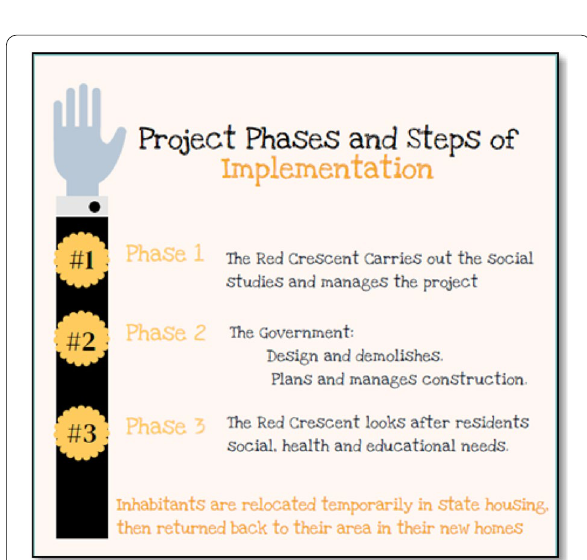
Fig. 9 Zinhum Housing Project Phases and steps of